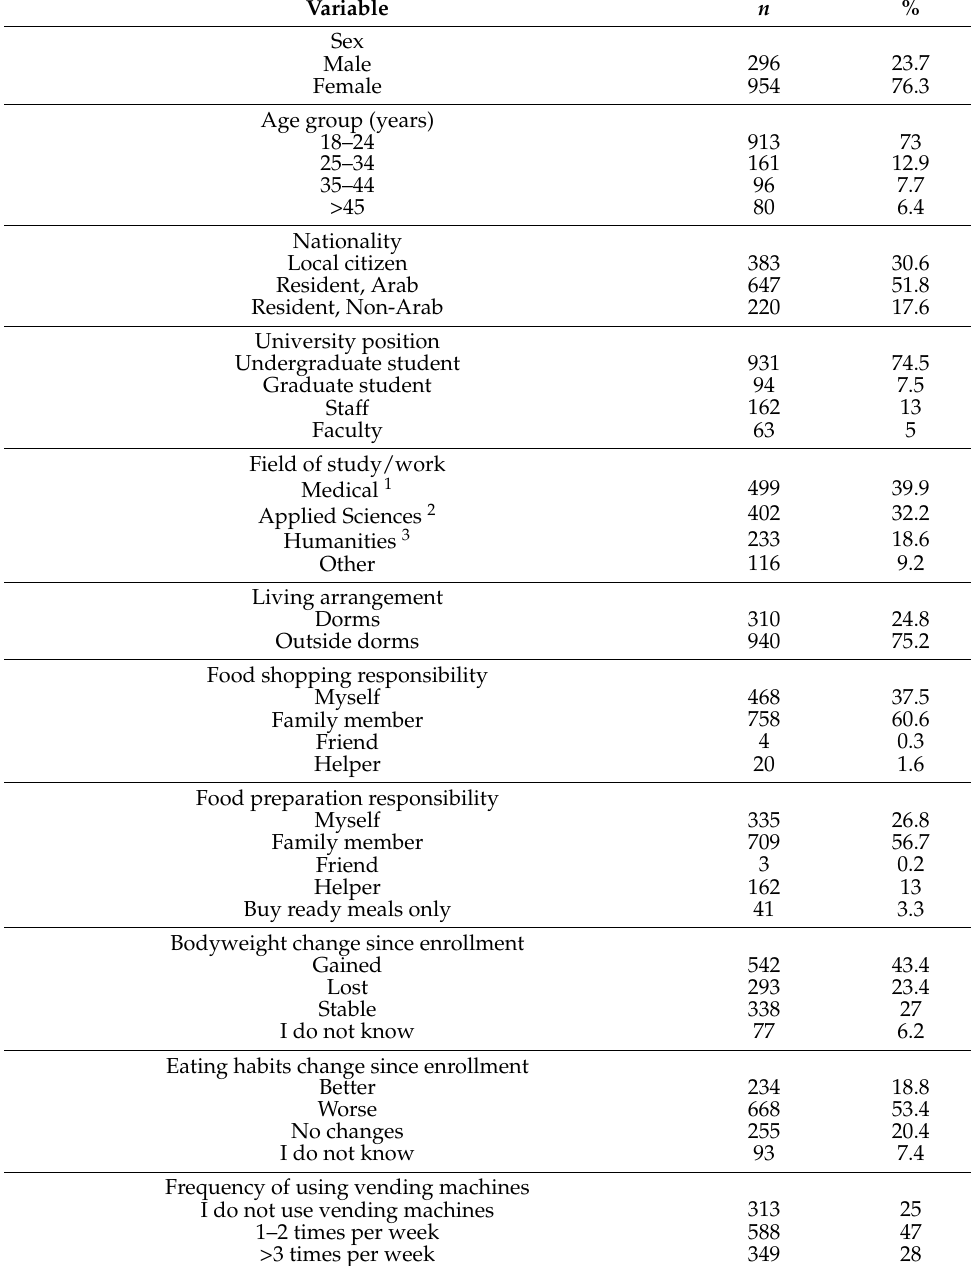
Table 1. Sociodemographic characteristics of the participants ( n =